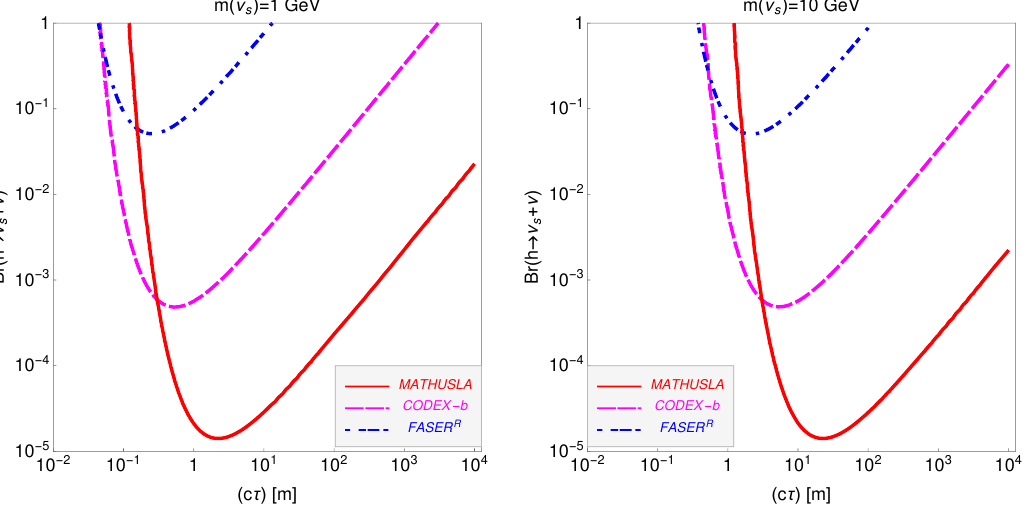
Figure 3 . Sensitivity estimates in the plane branching ratio versus decay length time ( c(cid:28) ) for CODEX-b, FASER and MATHUSLA. The plot to the left is for neutral fermions with a mass of 1 GeV, to the right 10 GeV, both for Higgs